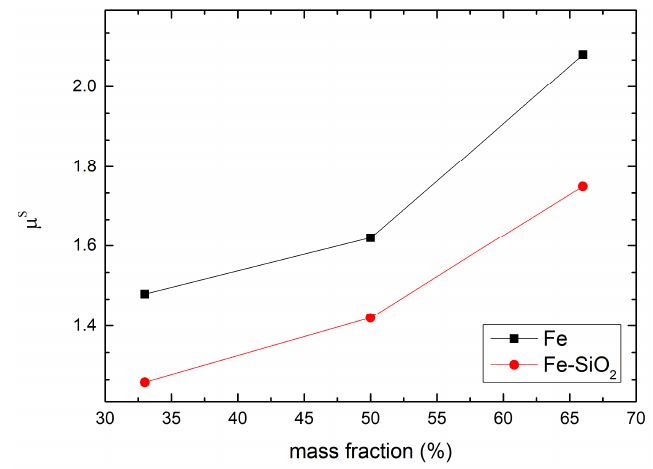
Figure 9. Static real permeability ( µ s ) dependences on the filler concentration for the “Fe”-wax and the “Fe@SiO 2 ”-wax composites. Table 1. Static real permeability ( µ s ) for the “Fe”-wax and the “Fe@SiO 2 ”-wax composites. Filler Concentration µ s , “Fe”-Wax Composite µ s , “Fe@SiO 2 ”-Wax Composite 33